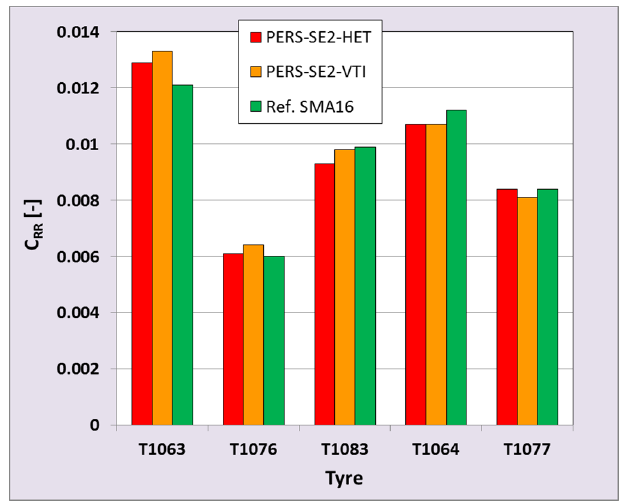
Figure 11. Rolling resistance results obtained during measurements on test section PERS ‐ SE2.